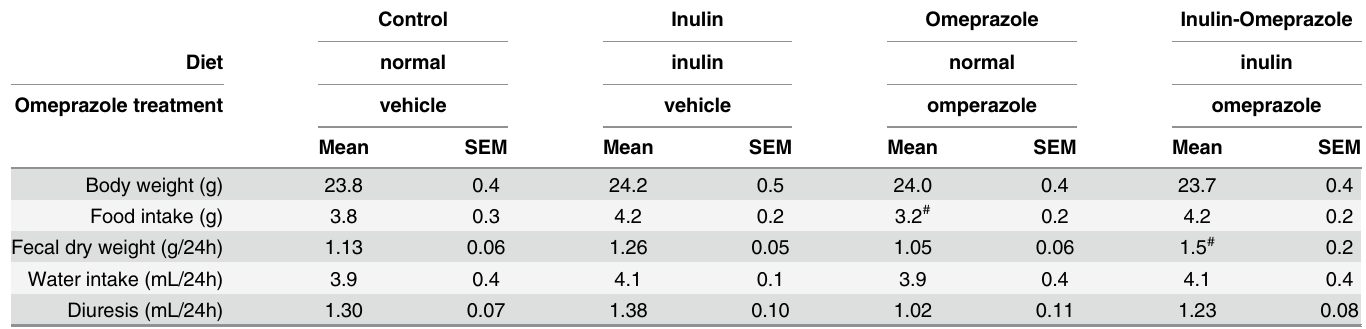
Table 1. Metabolic parameters of the